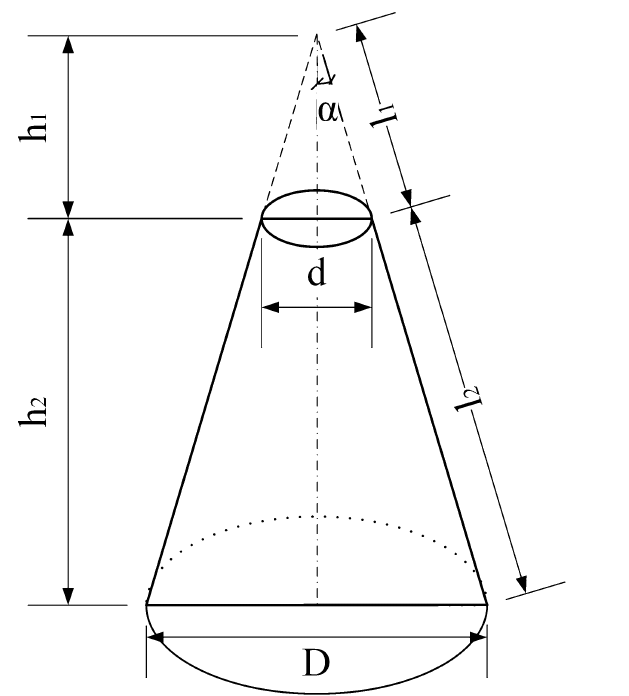
Figure 21. Calculation principle of bell superficial